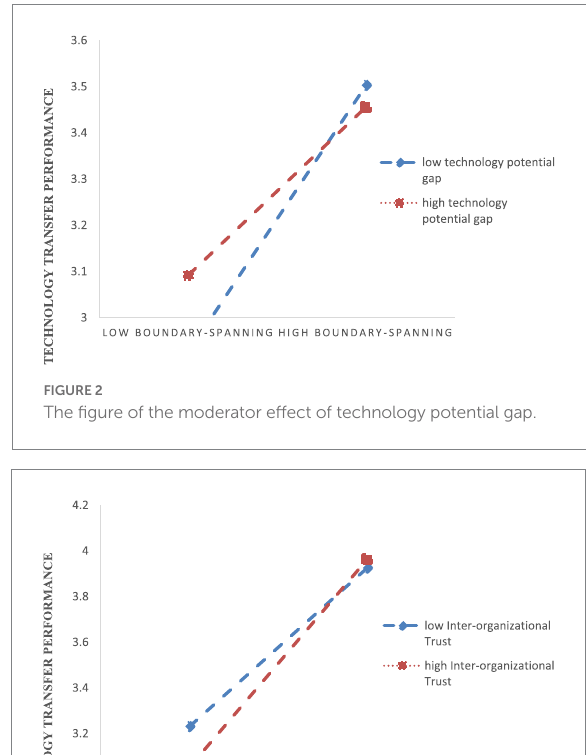
FIGURE 3 The figure of the moderator effect of inter-organizational